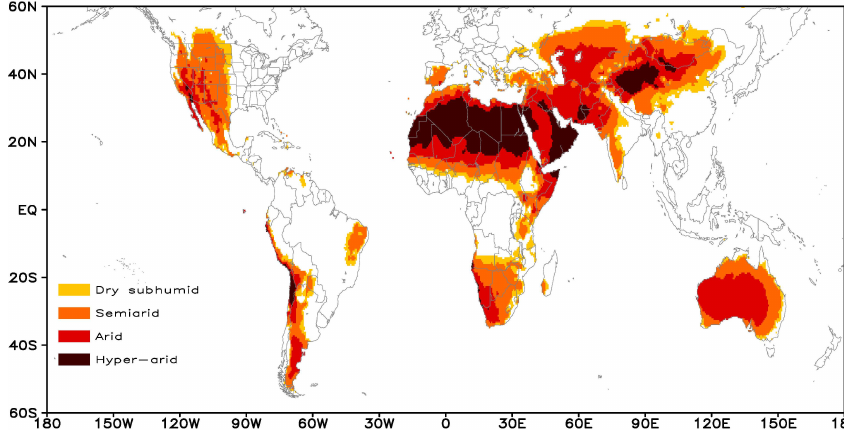
Fig. 1. Global distribution of drylands for 1961–1990 climatology derived from P /PET ratio based on